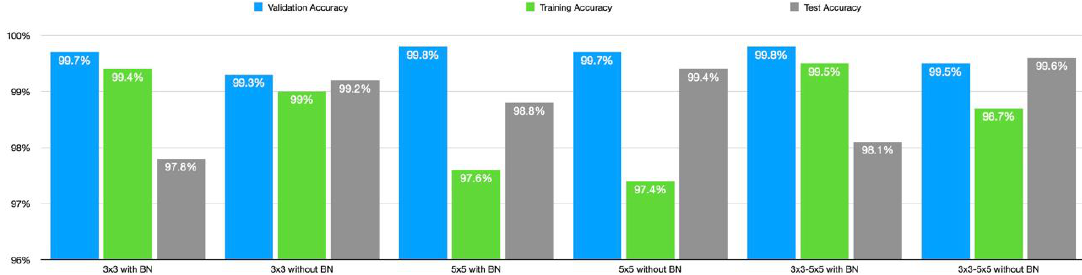
Figure 3. Comparison of the three proposed lightweight models in terms of accuracy.